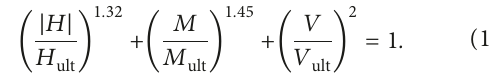
Fitted curve by binomial function